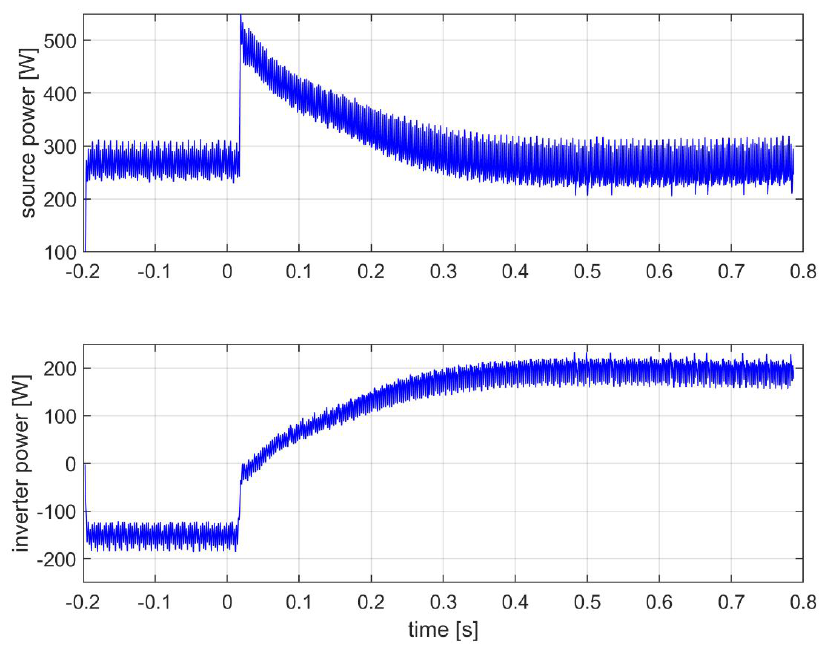
Figure 14. Source and inverter power when the additional load is